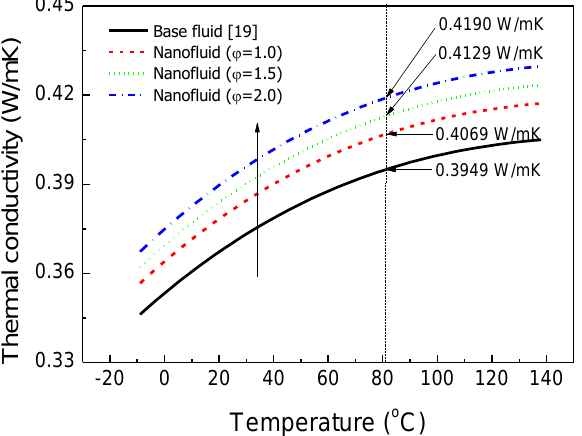
Figure 7. Thermal conductivity modeling of the base fluid and Al 2 O 3 nanofluids.